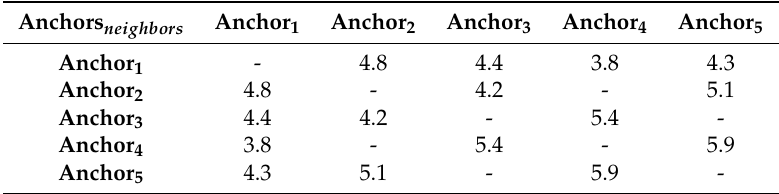
Figure 3. Path-loss exponents among anchor nodes. Table 2. Path-loss exponents among anchor nodes calculated through the Equation (3) using the RSSI values from the Table